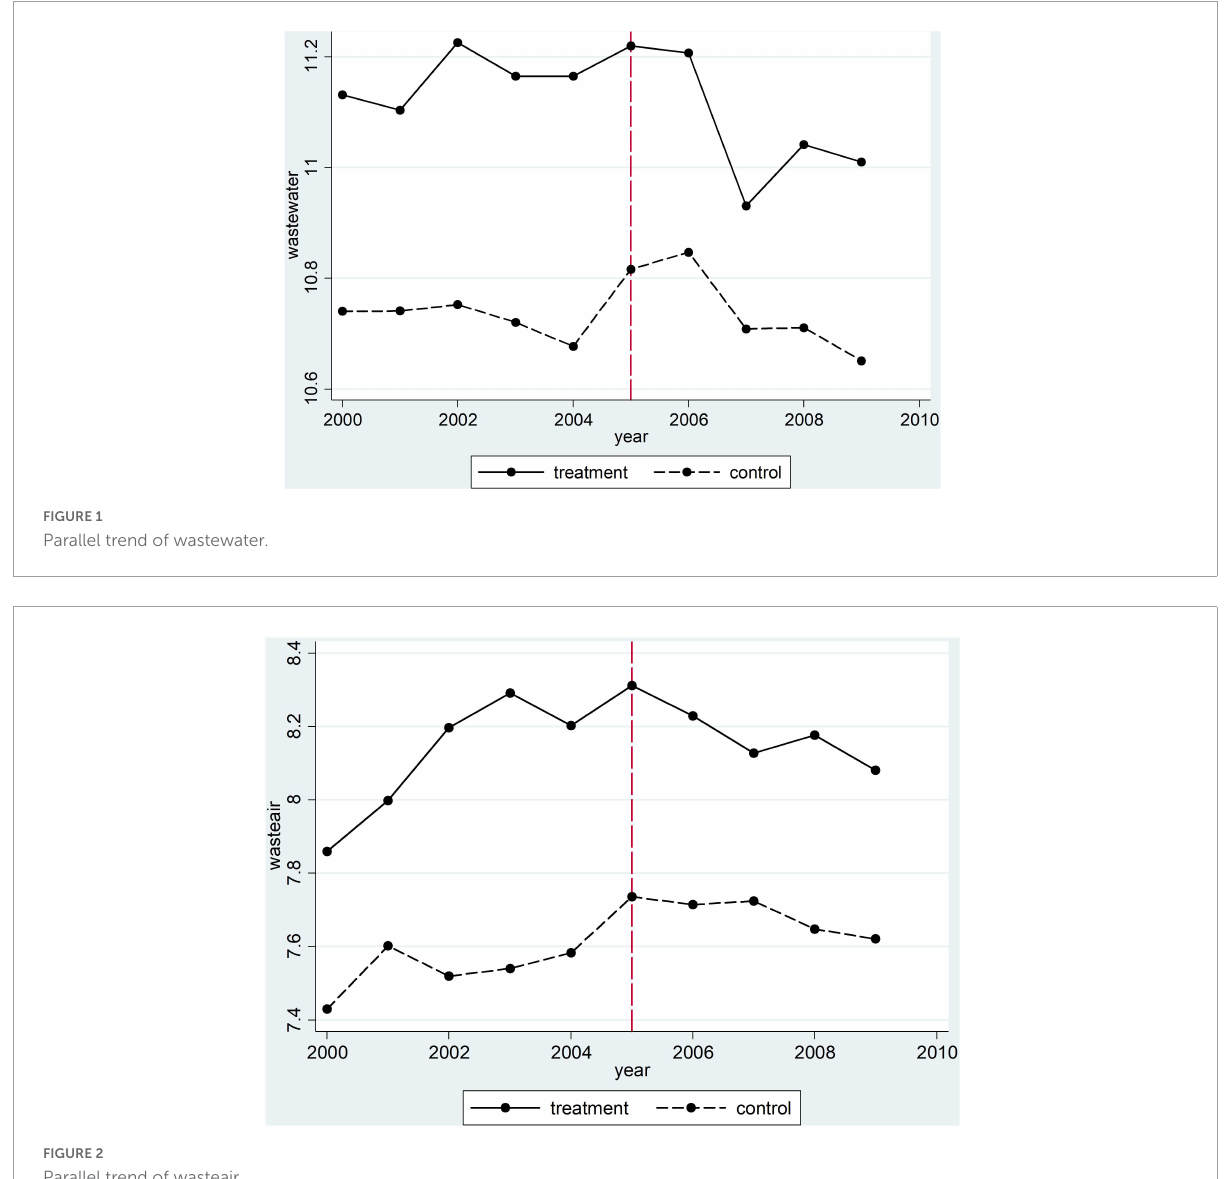
FIGURE2 Parallel trend of